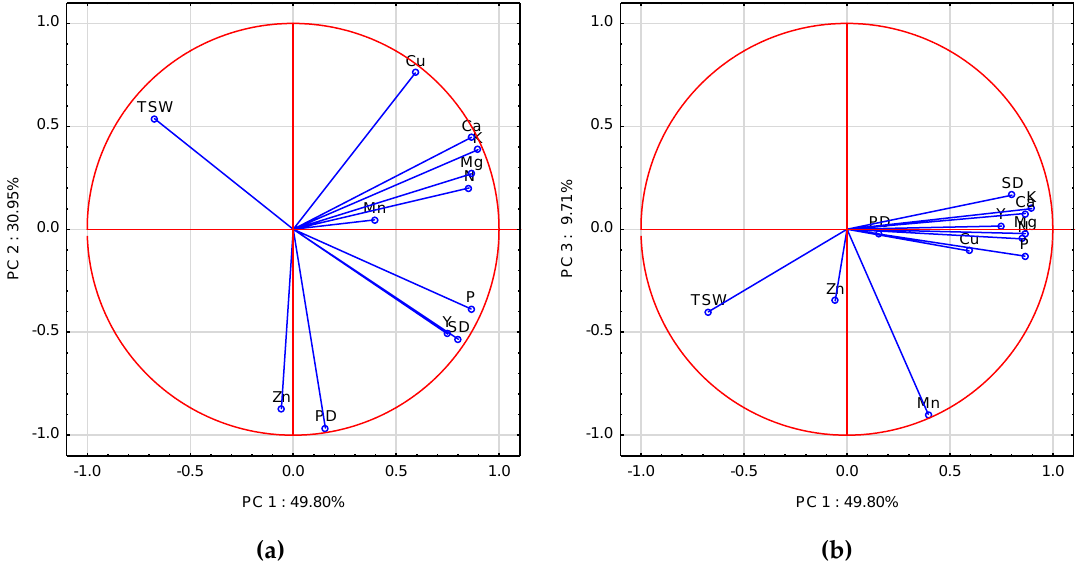
Figure 6. ( a ) Score plot of WOSR components and a particular Post-flowering Nutrient Uptake in PC1 and. PC2 axes. ( b ) Score plot of WOSR components and a particular Nutrient Post-flowering Uptake in PC1 and PC3 axes. Y—Yield, SD—Seed Density, PD—Pod Density, TSW—Thousand Seed Weight, N, P, K, Mg, Ca, Mn, Zn, Cu — nutrients.